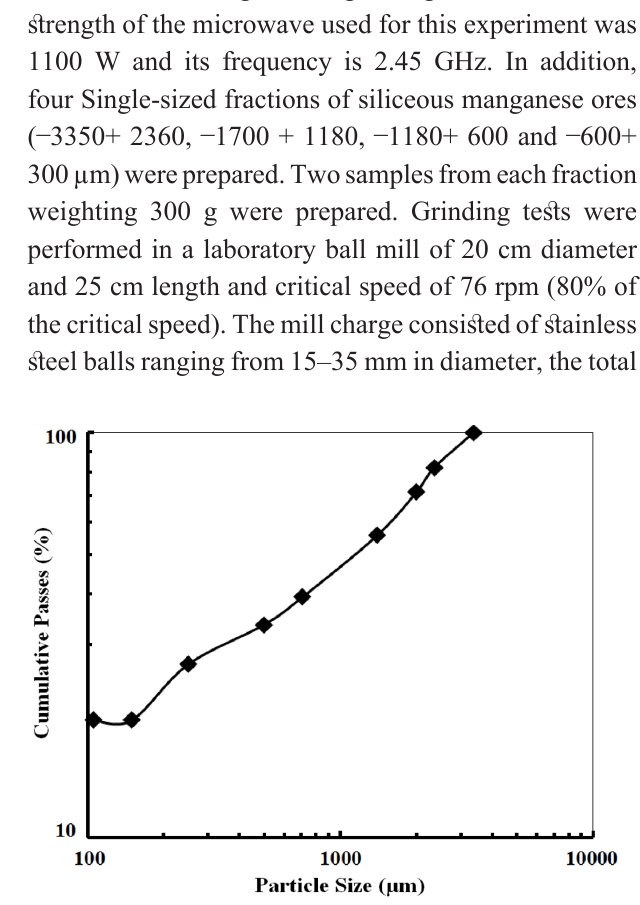
Fig. 1. Particles size distribution of manganese ore.